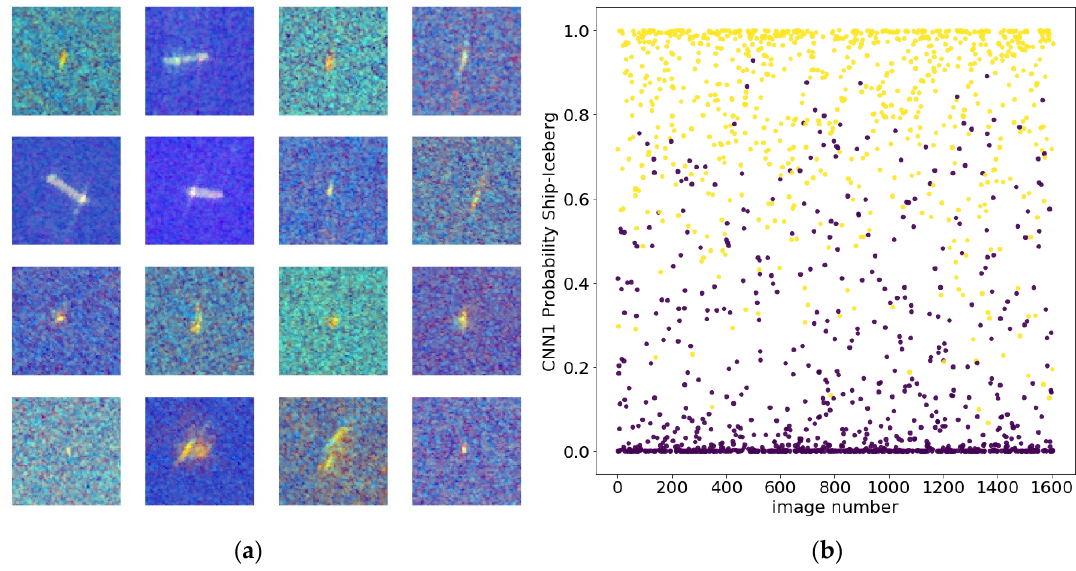
Figure 4. ( a ) Samples of ships and icebergs(top and bottom rows respectively) false-color images from the SAR dataset; ( b ) Scatter plots of the annotated S1 SAR dataset of ships (blue) and icebergs (yellow). The probabilities range from 0 (ship) to 1 (iceberg) and are calculated by the deep neural network described below and plotted vs. image number.